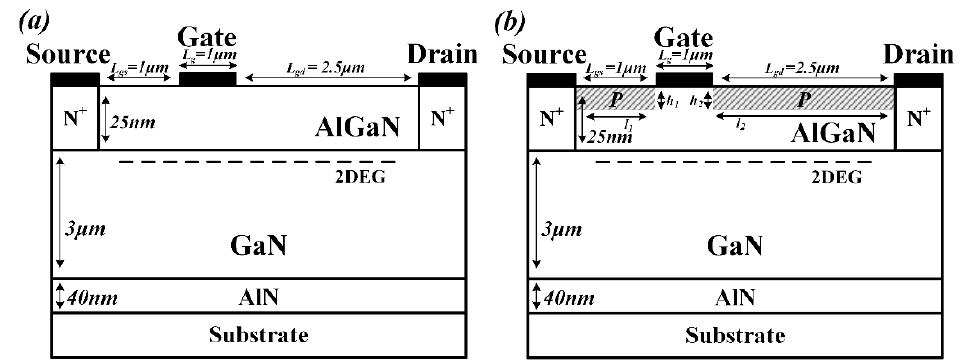
Figure 1. Schematic cross − sections of the ( a ) Con − HEMT, ( b ) PDBS − HEMT.